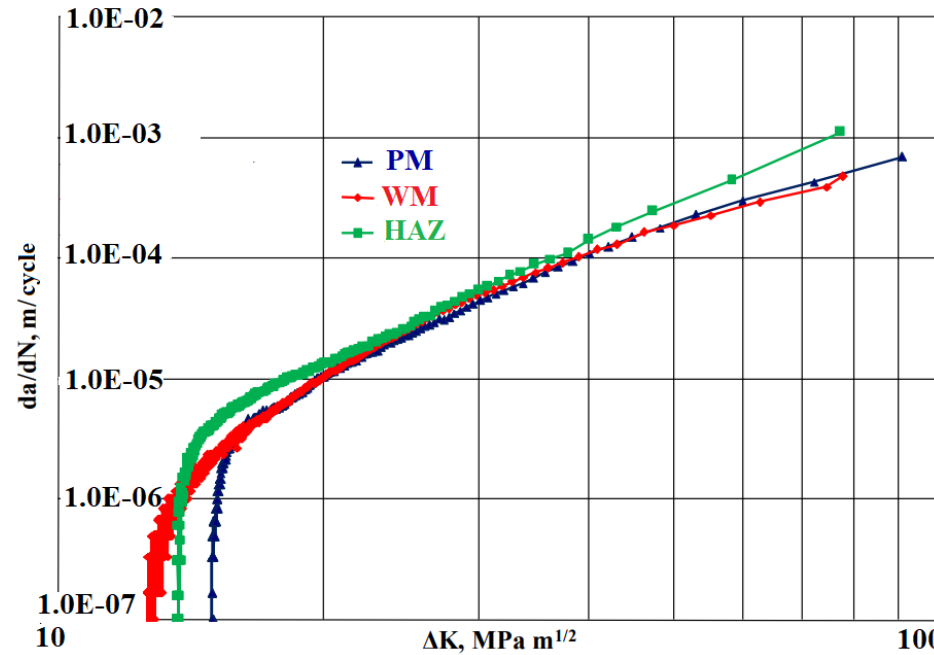
Figure 6. Crack growth rate da/dN vs. stress intensity factor range Δ K for welded joint constituents